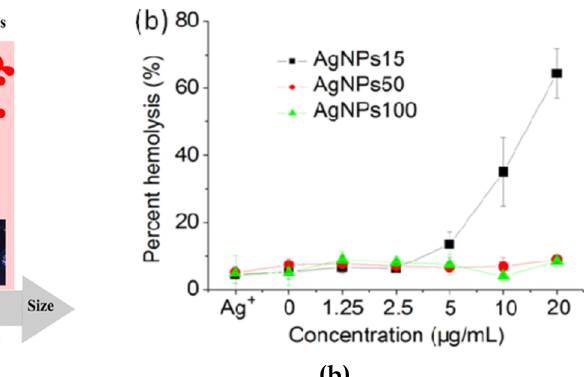
Figure 21. Dose-and time-dependent MMP reduction of HepG2 cells exposed to AgNPs in ( A ) deionized water and ( B ) cell culture medium. Data are expressed as means ± SD. There was significant difference between the treated and control groups (* p < 0.05; ** p < 0.01), and between the 24- and 48-h groups ( # p < 0.05). Reproduced from [194] with permission of Wiley.